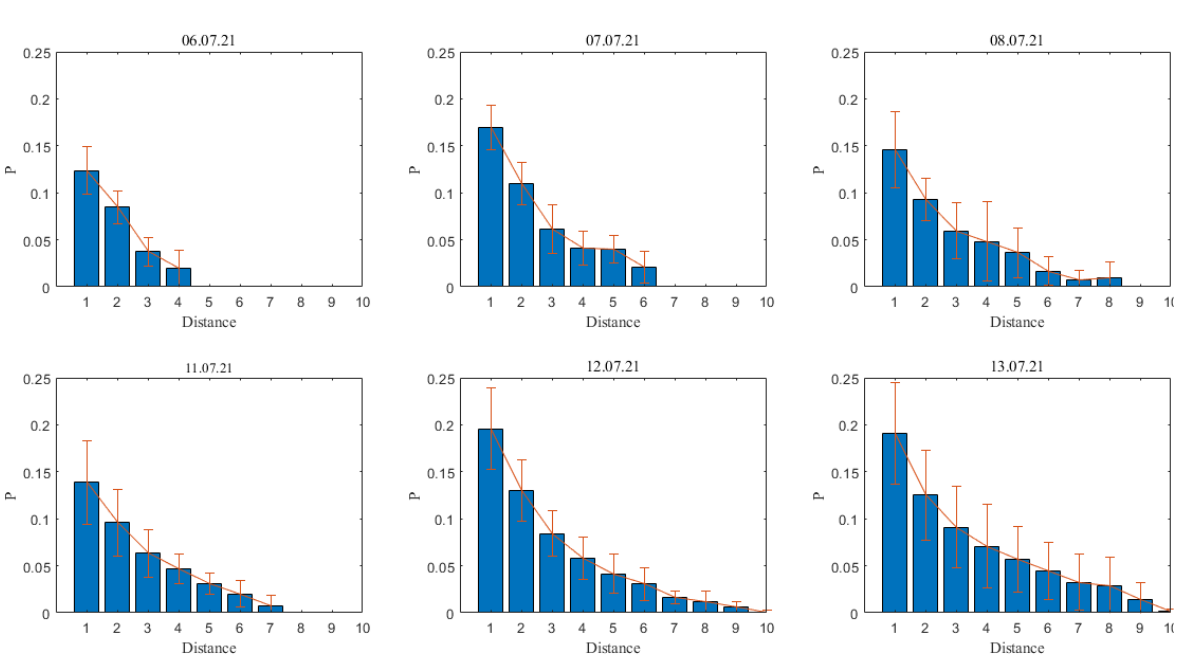
Figure 4 The effect of distance (D) from the nearest edge on mean misclassification probability (P) on 6 days of measurments. Distance is measured in pixels. As the distance from the nearest edge increase the probability for misclassification decreases. The mean was calculated based on 5 different sowing plates. Error bars represent the probabilities’ standard deviation.